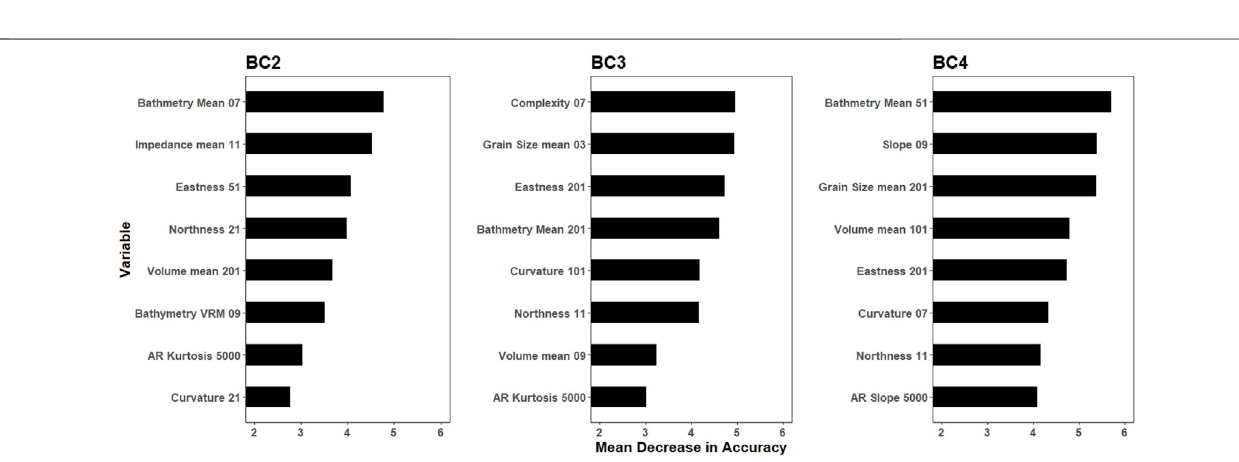
Frontiers in Remote Sensing |